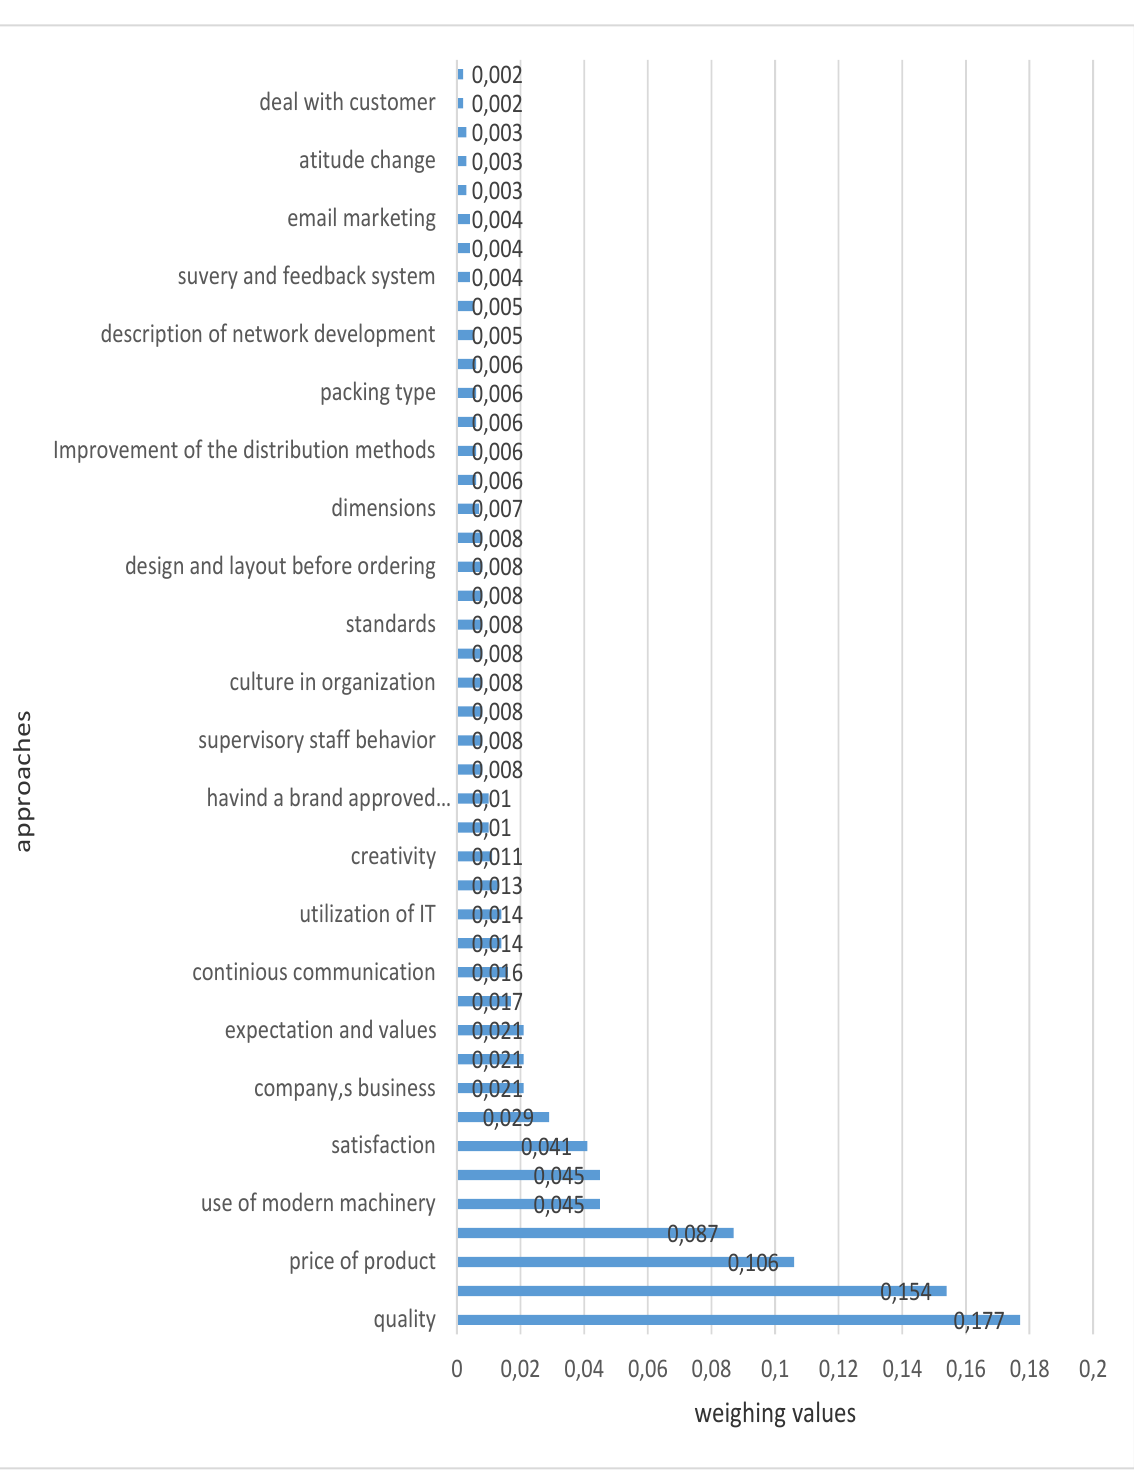
Figure 15: Overall synthesize of result of reputaion effective criteria in administrative furniture industry (Inconsistency